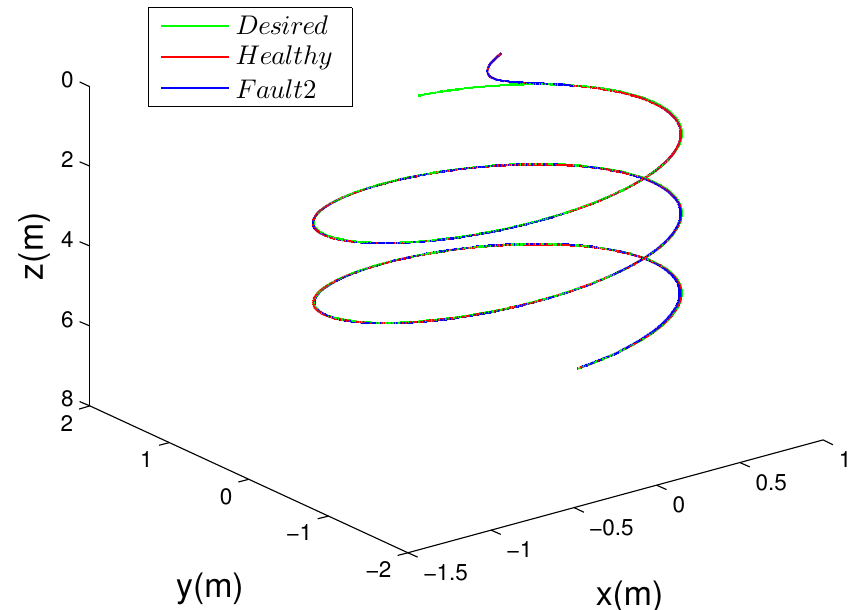
Figure 8. The 3-D trajectory tracking results with fault